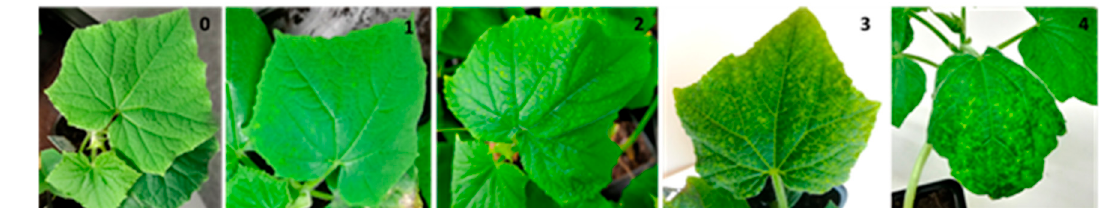
Figure 1. Symptom scoring in cucumber plants showing ToLCNDV symptoms corresponding to the scale: 0 absence of symptoms, 1: mild symptoms, 2: moderate symptoms, 3: severe symptoms, and 4: very severe symptoms or dead plant.